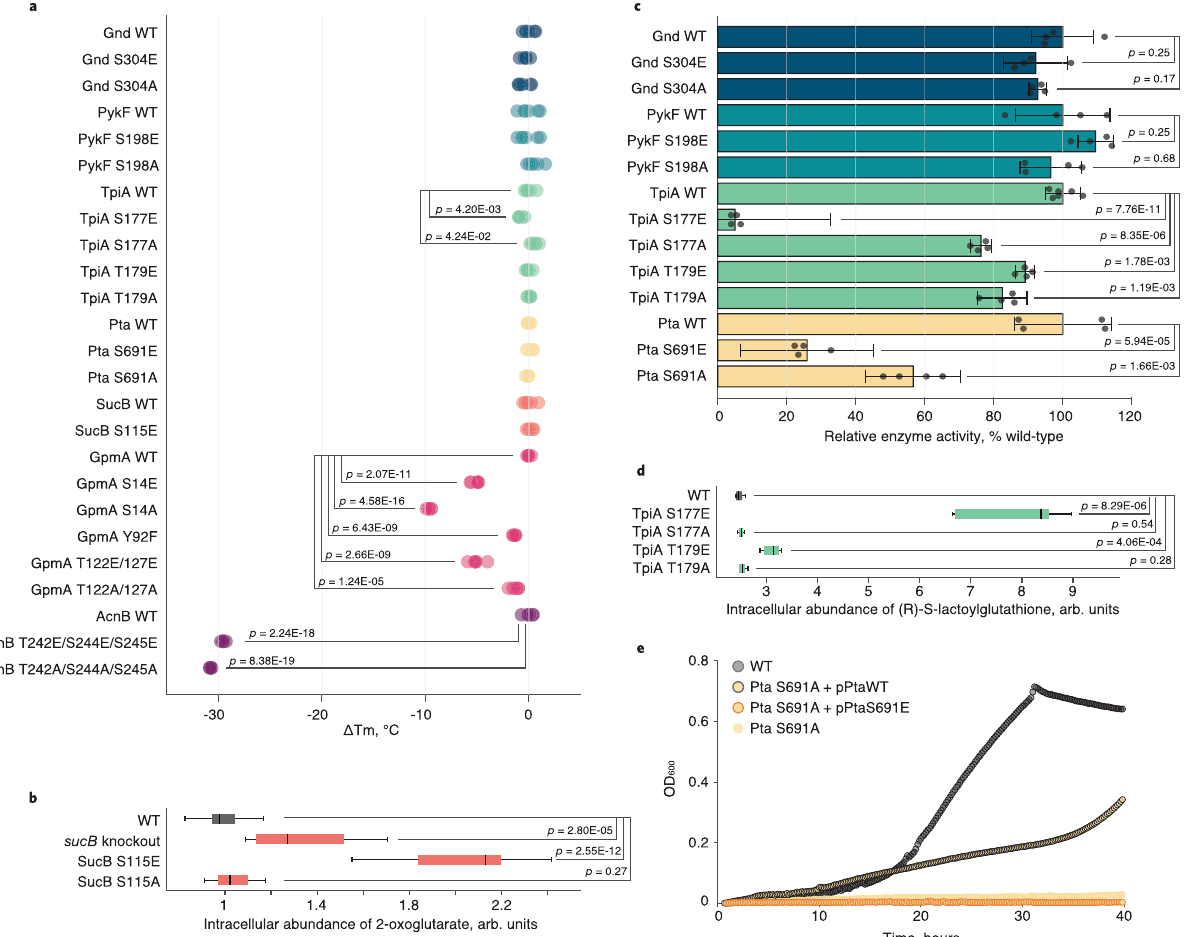
Fig. 3 Substantial effects of phosphosite perturbation. a Change in thermal stability of puri fi ed (phosphomutant) enzymes. For each of the six replicates, the difference between its melting temperature and the average melting temperature of the respective wild-type enzyme ( Δ T m ) is plotted. b Intracellular abundance of 2-oxoglutarate in phosphomutants of SucB S115, the sucB knockout and the wild-type E. coli during growth on minimal medium with fructose. n = 10, 3, 4, 5 biological replicates with two technical replicates were measured for the wild-type, knockout, S115E, S115A mutants, respectively. c Relative activity of puri fi ed wild-type and phosphomutant enzymes, determined as the maximum initial reaction rate. Data represent the mean ± standard deviation. The following substrate concentrations were used: Gnd — 5 mM 6-phosphogluconate, 1 mM NADP + ; PykF — 2 mM phosphoenolpyruvate, 1 mM ADP; TpiA — E. coli during growth on minimal medium with glucose. n = 3 biological replicates with two technical replicates were measured for each strain. For ( a – d ) statistical signi fi cance was calculated with a two-tailed unpaired t -test and p -values (in ( b , d ) Benjamini – Hochberg adjusted) are indicated. Box ’ s length in ( b , d ) represents the IQR, the central mark shows the median, the whiskers span 1.5 times IQR. e Rescue of Pta S691A lethality on minimal medium with acetate. Acetate growth curves for wild-type, Pta S691A, and Pta S691A containing the plasmid carrying either wild-type Pta, or Pta S691E are shown. Source data are provided as a Source Data fi